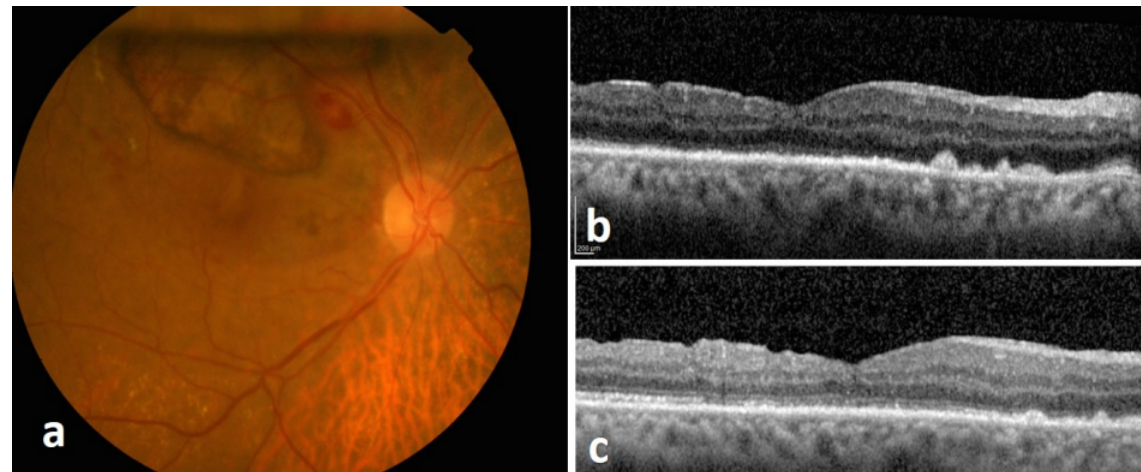
Figure 3: a) The clinical photograph taken 1 month after the initial presentation shows resolution of the subretinal hemorrhage with remained pigmentary changes and anatomical closure of the macular hole. b) OCT scan 1 week after surgery shows restoration of the external limiting membrane. c) OCT scan 1 month after the surgery shows that the ellipsoid zone is also